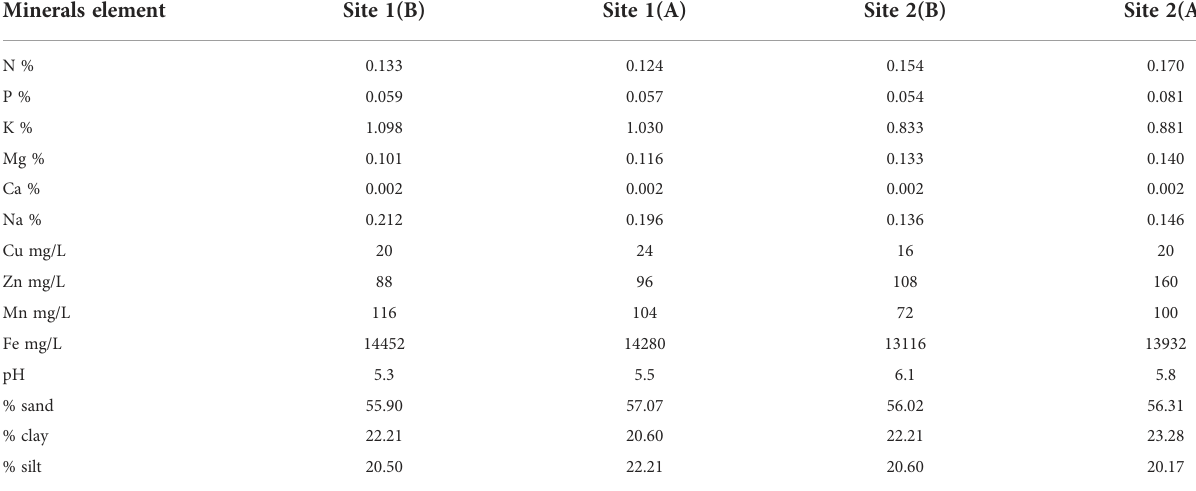
TABLE 2 Physicochemical properties of the soil before and after planting. Minerals